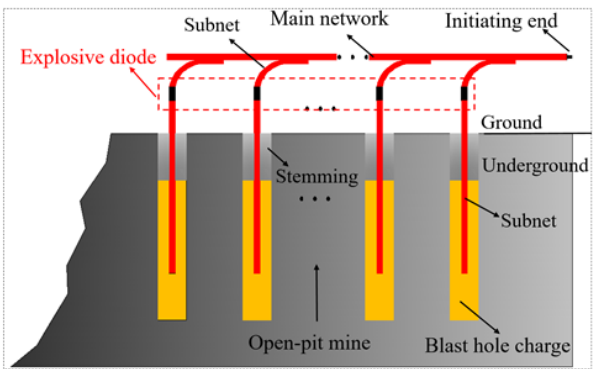
Figure 9. Schematic diagram of the application of the new explosive logic network.